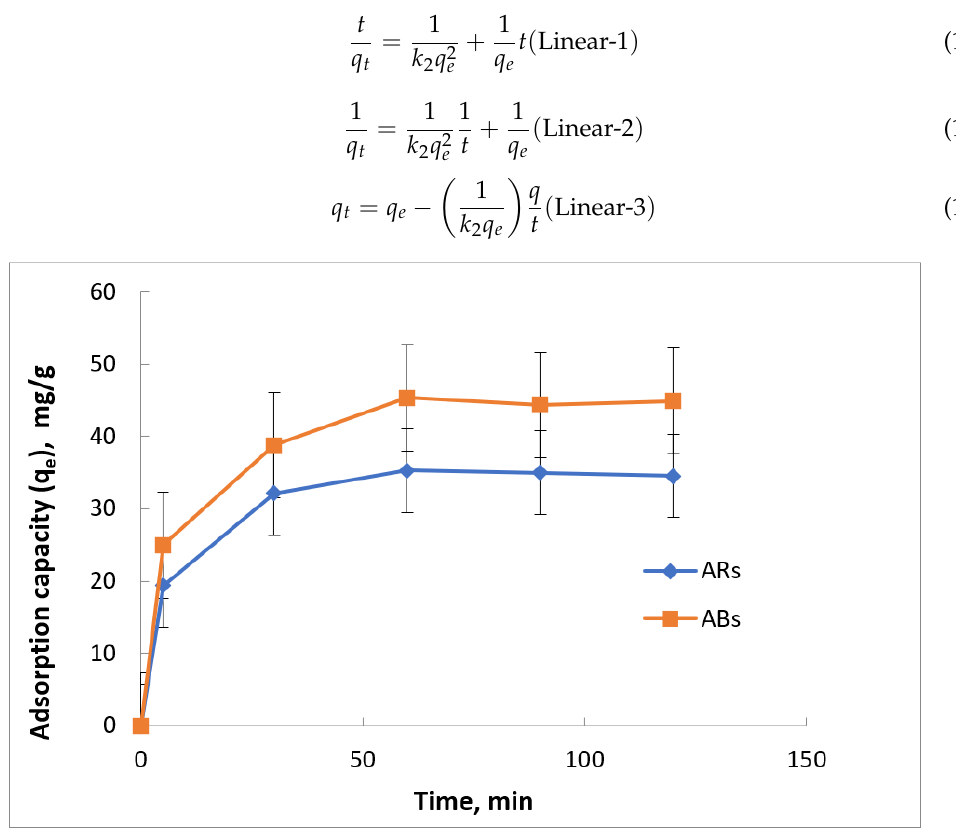
Figure 16. The effect of contact time on the adsorption capacity of oil onto AB adsorbent (1 g ABs, pH 6.5, Temp. 25 ° C).